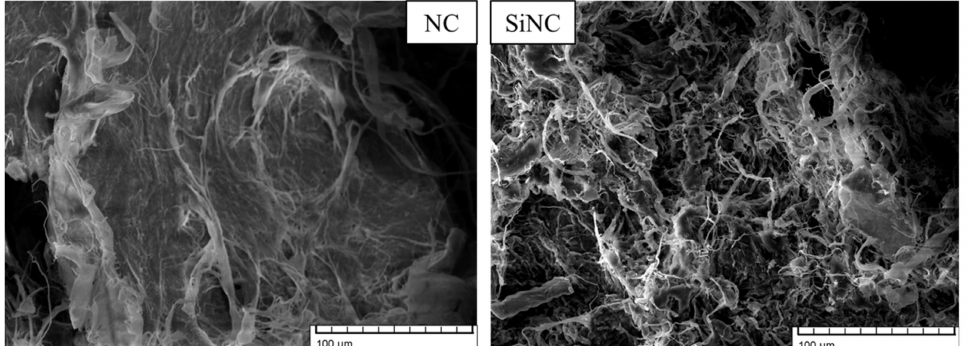
Figure 6. SEM images of nanocellulose (NC) and silanized nanocellulose (SiNC).